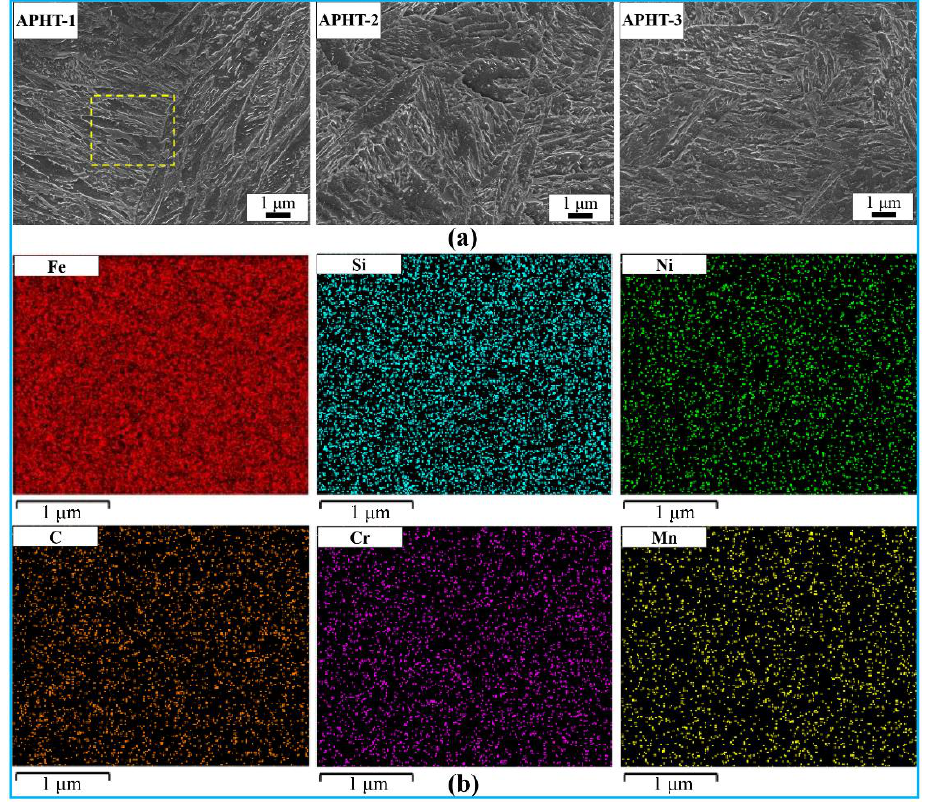
Figure 4. Microstructure images of three samples. ( a ) SEM micrograph of APHT-1, APHT-2 and APHT-3. ( b ) EDS maps of APHT-1. The yellow dotted lines in the APHT-1 provide a visual reference for EDS maps.